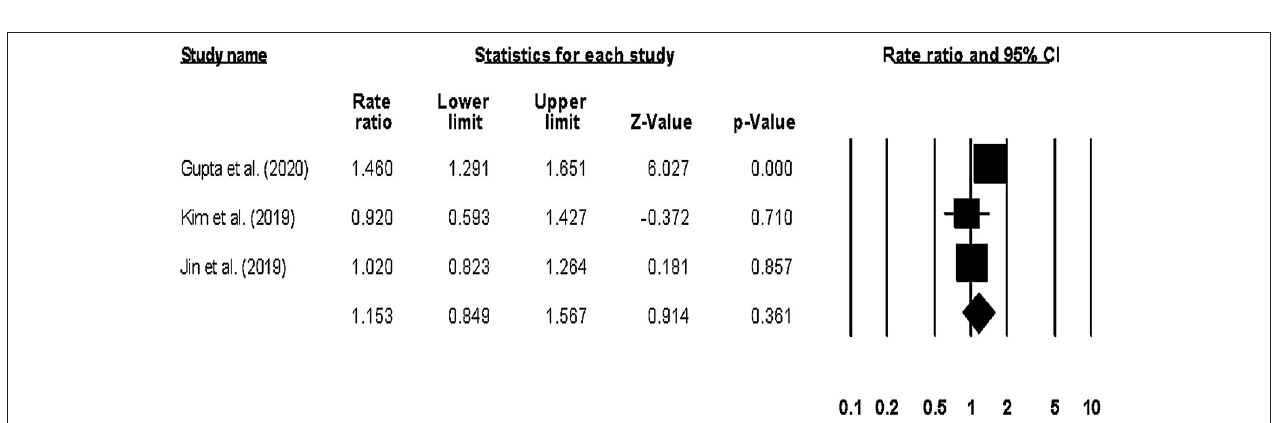
FIGURE 8 | Forest plot for studies evaluating the overall hospitalization outcome. The adjusted odds ratios are presented as black boxes, whereas 95% confidence intervals are presented as whiskers. A negative odds ratio represents a reduction in the risk of mortality in heart failure patients with anemia, whereas the positive odds ratio represents an increase in the risk of mortality in heart failure patients with anemia.